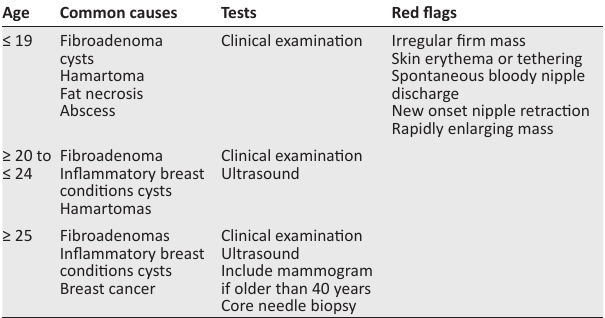
TABLE 2: Common causes and tests required in the investigation of a breast lump based on